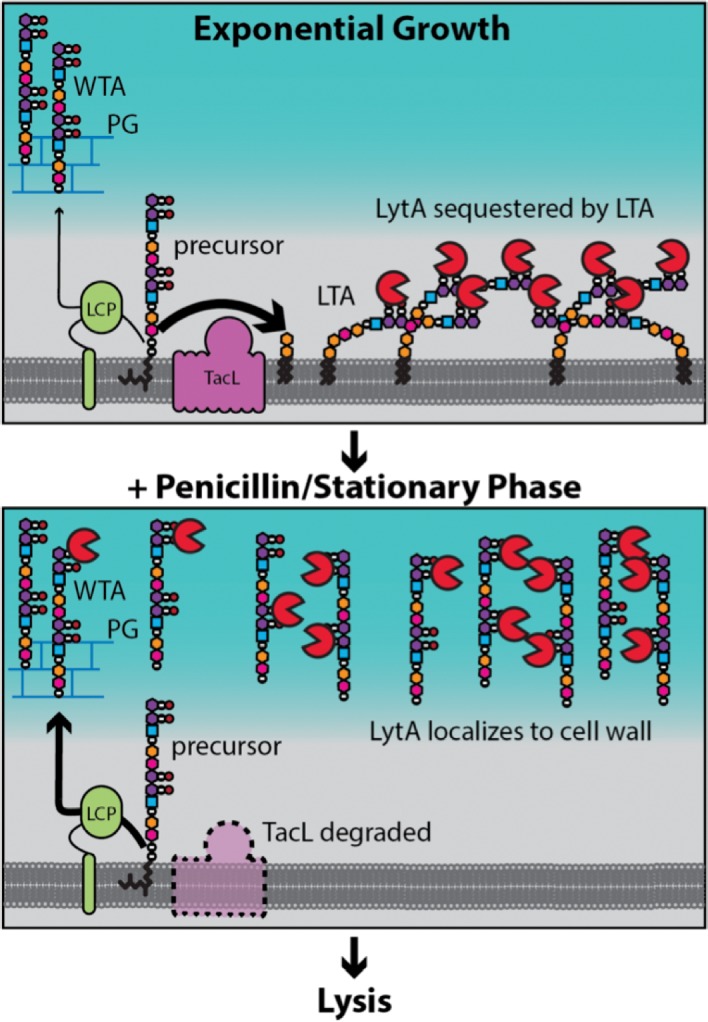
Model for LytA regulation.During exponential growth, TacL-dependent LTA synthesis dominates over LCP-dependent production of WTA. LytA bound to the phosphocholine moeities (purple/black balls) on LTA is sequestered away from WTA preventing LytA from targeting the cell wall. Upon entry into stationary phase or exposure to cell wall targeting antibiotics (penicillin), TacL is degraded in an FtsH-dependent manner leading to a reduction in LTA synthesis and an increase in WTA levels. Association of LytA with newly synthesized WTA leads to cell wall cleavage and lysis.